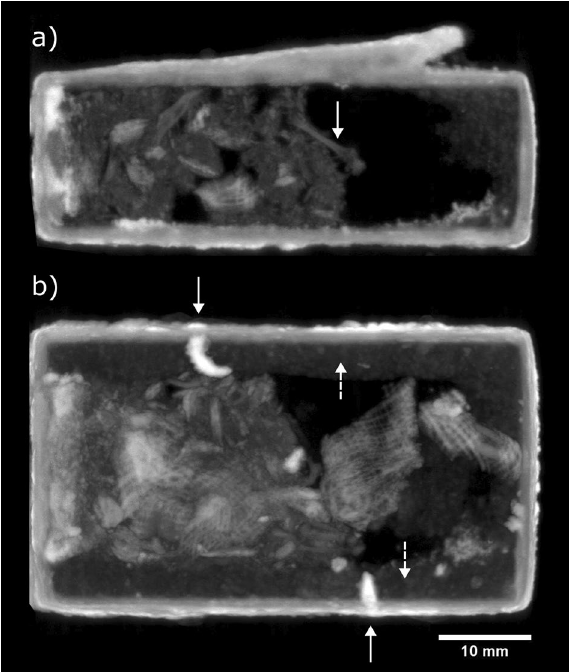
Figure 1. EA27584 multiplanar maximum intensity projection (MIP) neutron CT images: ( a ) side-view, 1.16 mm thick slice centred 6.1 mm from right side of box, highlighting the presence of an 8.1 mm long bone (solid arrow); ( b ) top-view, 12.43 mm thick slice centred 8.3 mm from base of box, showing the presence of textile, corroded chaplets (solid arrows), and core material (dashed